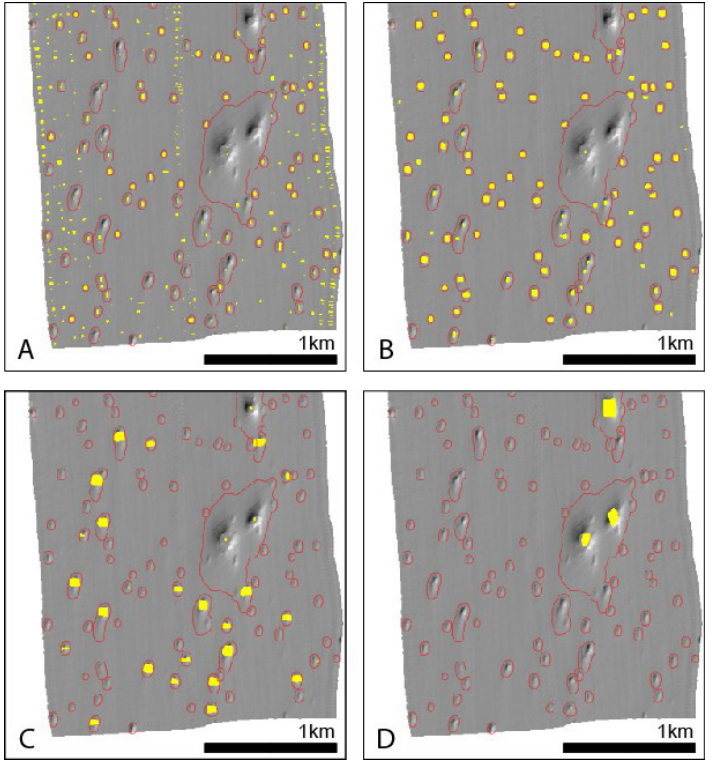
Figure 14. Examples of feature classification using different analysis window size. Background data - greyscale shaded relief image of bathymetry data. Pockmark features delineated by the BGS Mapping toolbox are shown in red for reference. ( A ) Pit features (yellow) from feature analysis using 9 × 9 rectangular neighbourhood; ( B ) Pit features (yellow) from feature analysis using 15 × 15 rectangular neighbourhood; ( C ) Pit features (yellow) from feature analysis using 27 × 27 rectangular neighbourhood; ( D ) Pit features (yellow) from feature analysis using 51 × 51 rectangular neighbourhood.